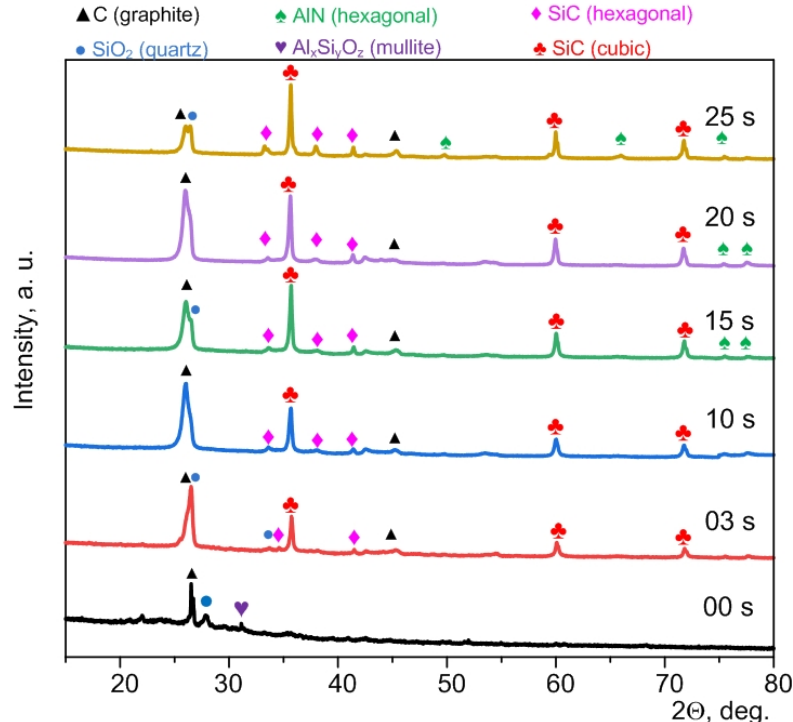
Figure 1. XRD patterns of the initial micropowder (00 s) and that processed by DC arc discharge plasma at different times: 3, 10, 15, 20, 25 s.